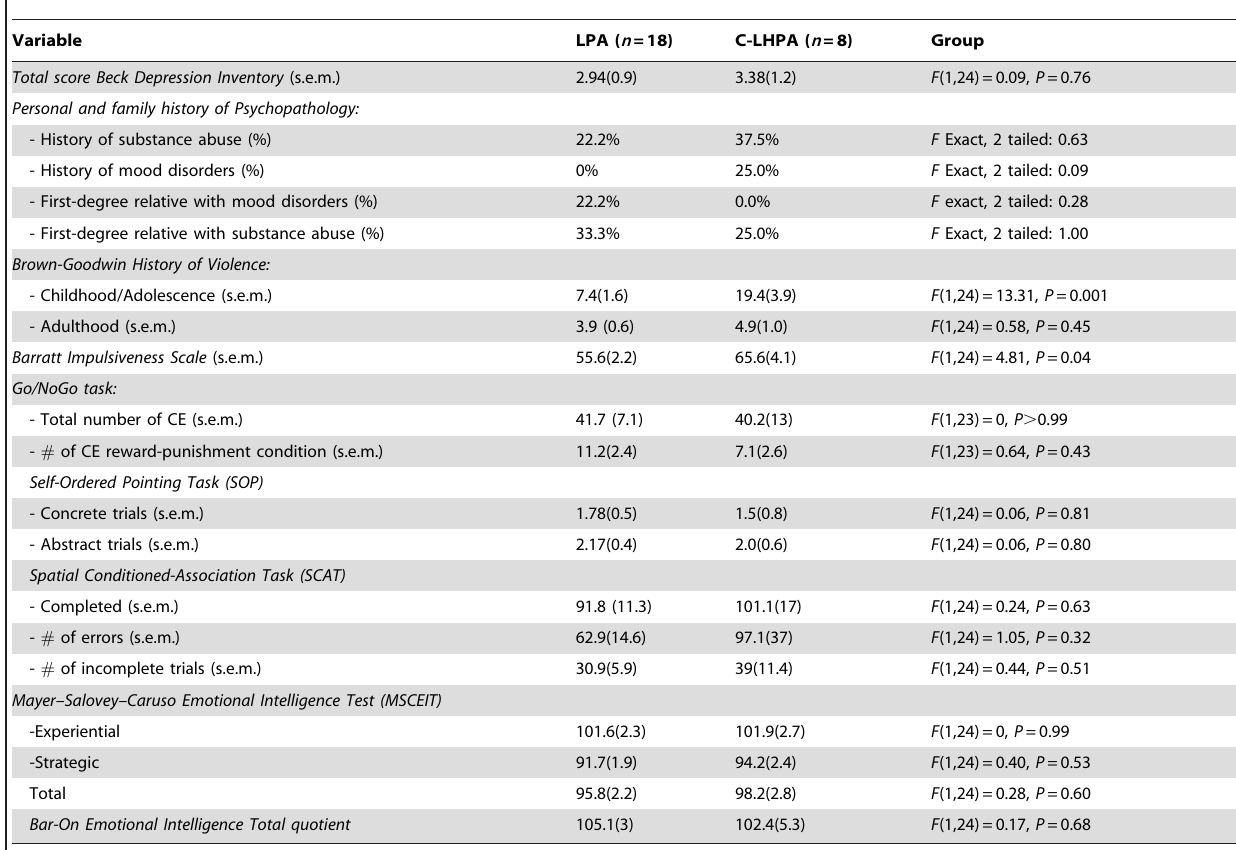
Table 1. Characteristics of the